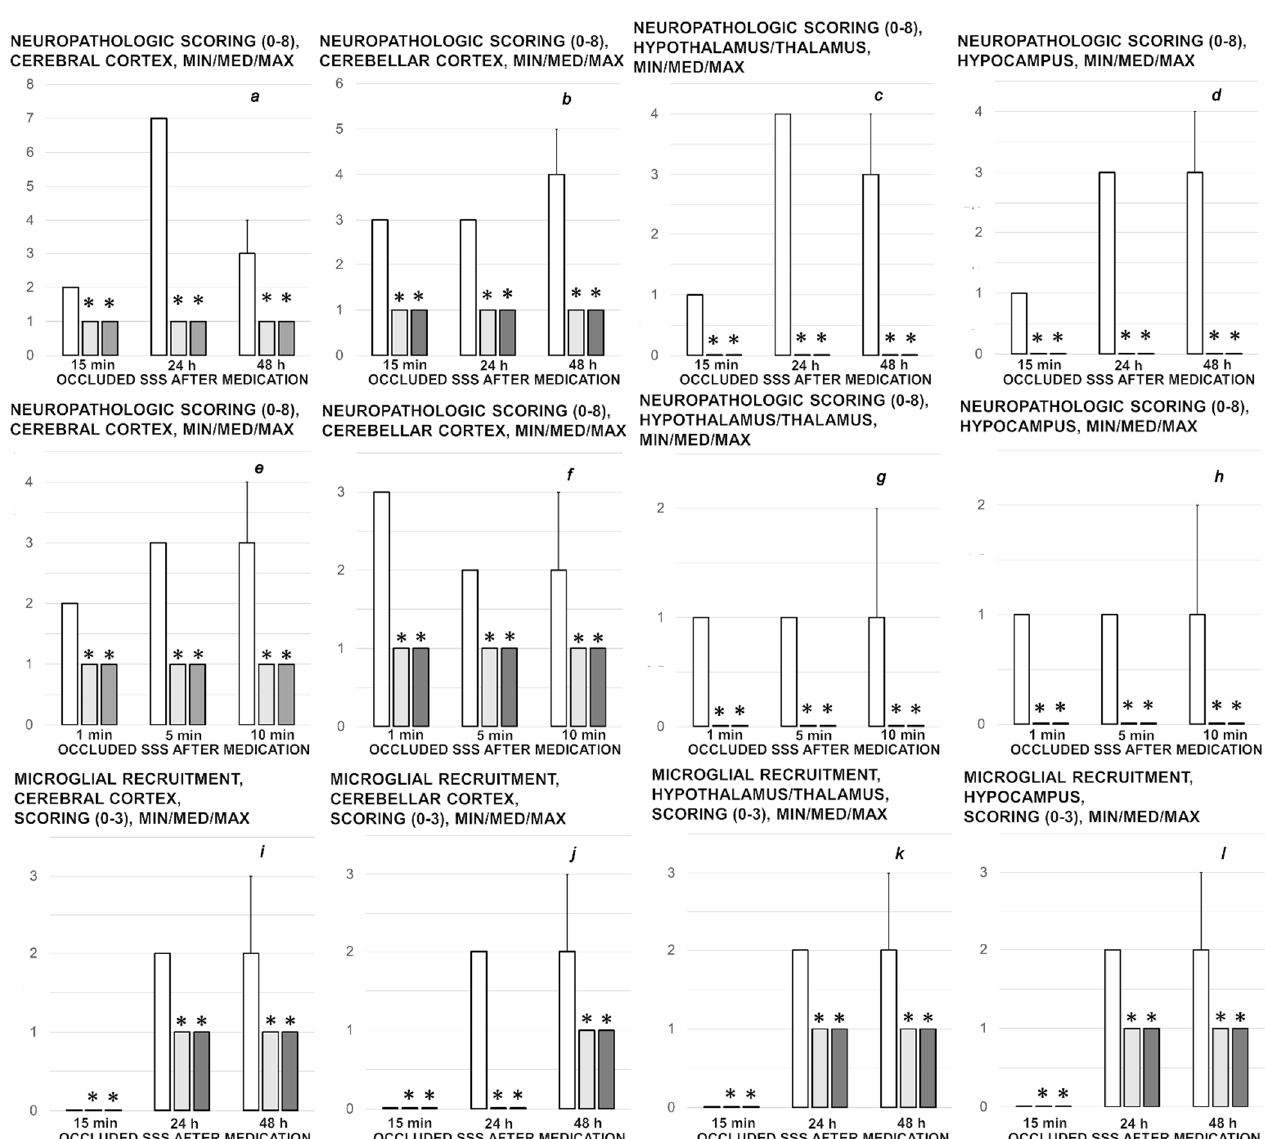
Figure 9. Neuropathologic scoring (necrosis + karyopiknosis) (0–8) ( a – h ), and microglial recruitment scoring (0–3) ( i – l ) in cerebral and cerebellar cortex, hypothalamus/thalamus and hippocampus after therapy (saline 5 mL/kg (white bars), BPC 157 10 µg/kg (light gray bars), 10 ng/kg (dark gray bars) given intragastrically at 1 min ligation time). Neuropathologic scoring (necrosis + karyopiknosis) (0–8) ( a – h ). Assessment carried out at 15 min, 24 h, and 48 h ligation-time ( a – d ) and at 1 min, 5 min and 10 min therapy-time ( e – h ). Microglial recruitment scoring (0–3) ( i – l ). Assessment at 15 min, 24 h, and 48 h ligation-time. Microglial recruitment was not present at 1 min, 5 min and 10 min therapy-time (data not specifically shown). The effects of the intraperitoneal and local application regimen, providing the similar results were not specifically shown. MIN/MED/MAX, * p ˂ 0.05, at least vs. corresponding control.